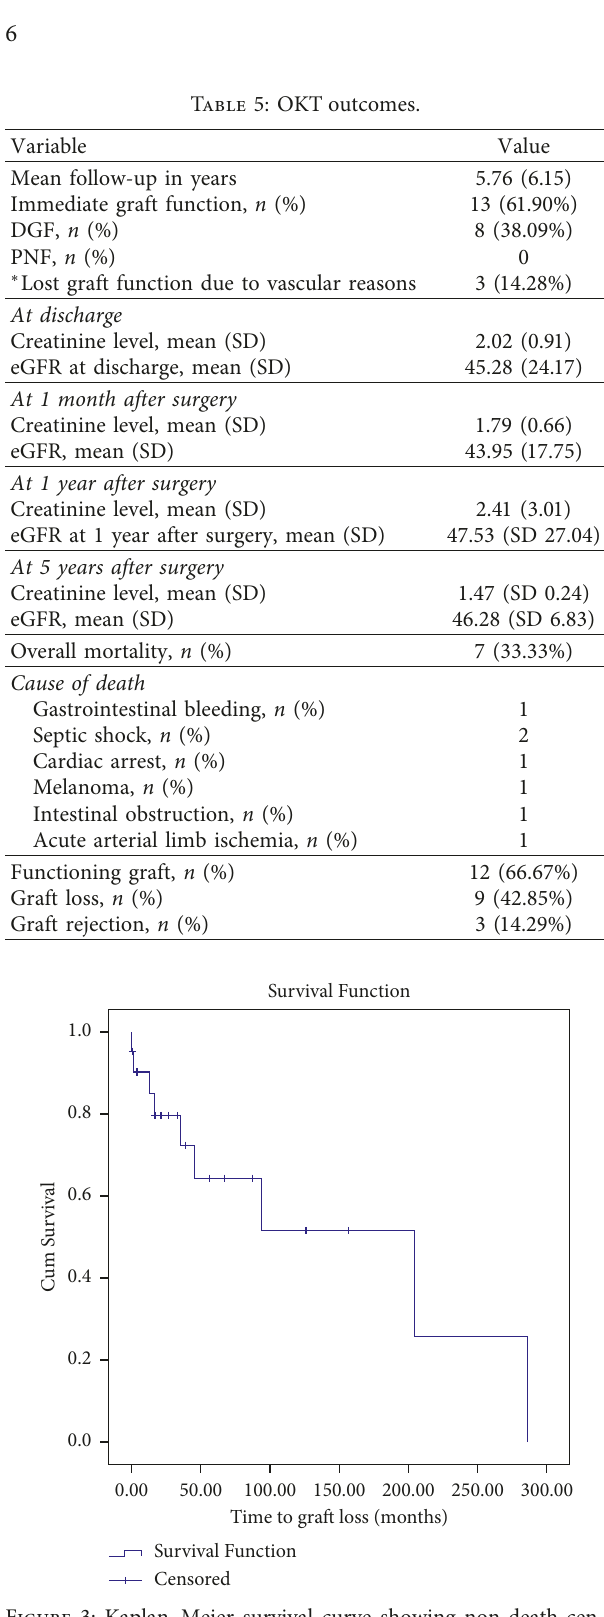
Figure 3: Kaplan–Meier survival curve showing non-death-cen- sored graft survival of OKT grafts.